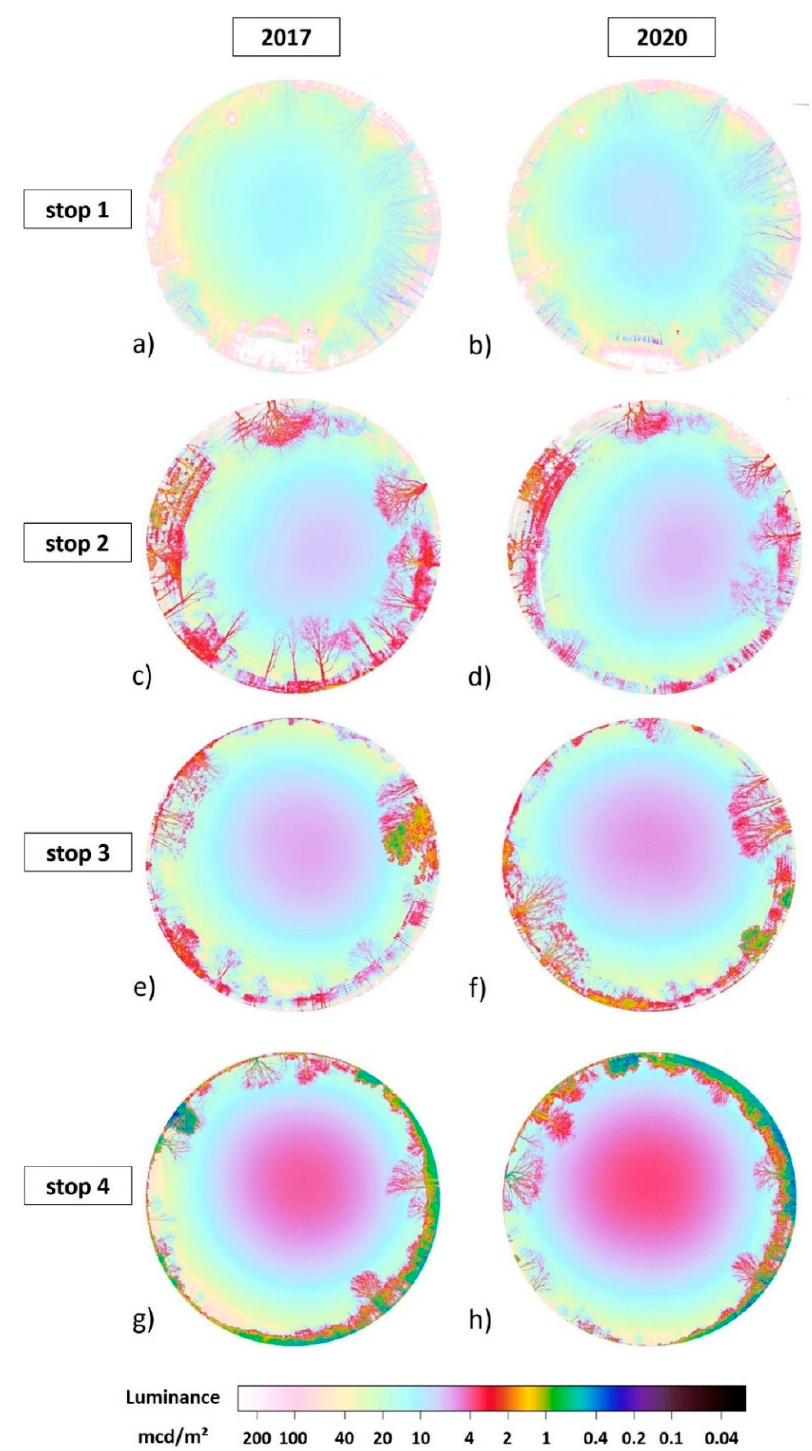
Figure A1. Luminance maps for stops 1–4. ( a , c , e , g ) 2017 data, ( b , d , f , h ) 2020 data.